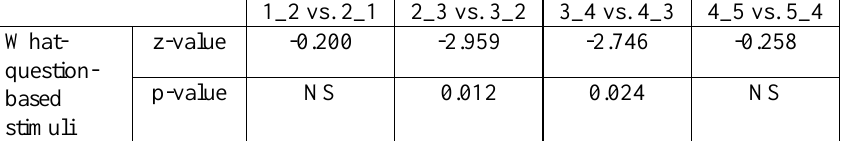
Table IX. z- and p-values of four Wilcoxon matched pairs signed rank tests comparing the “different” response rate between two conditions (AB order and BA order) for each pair of what-question-based